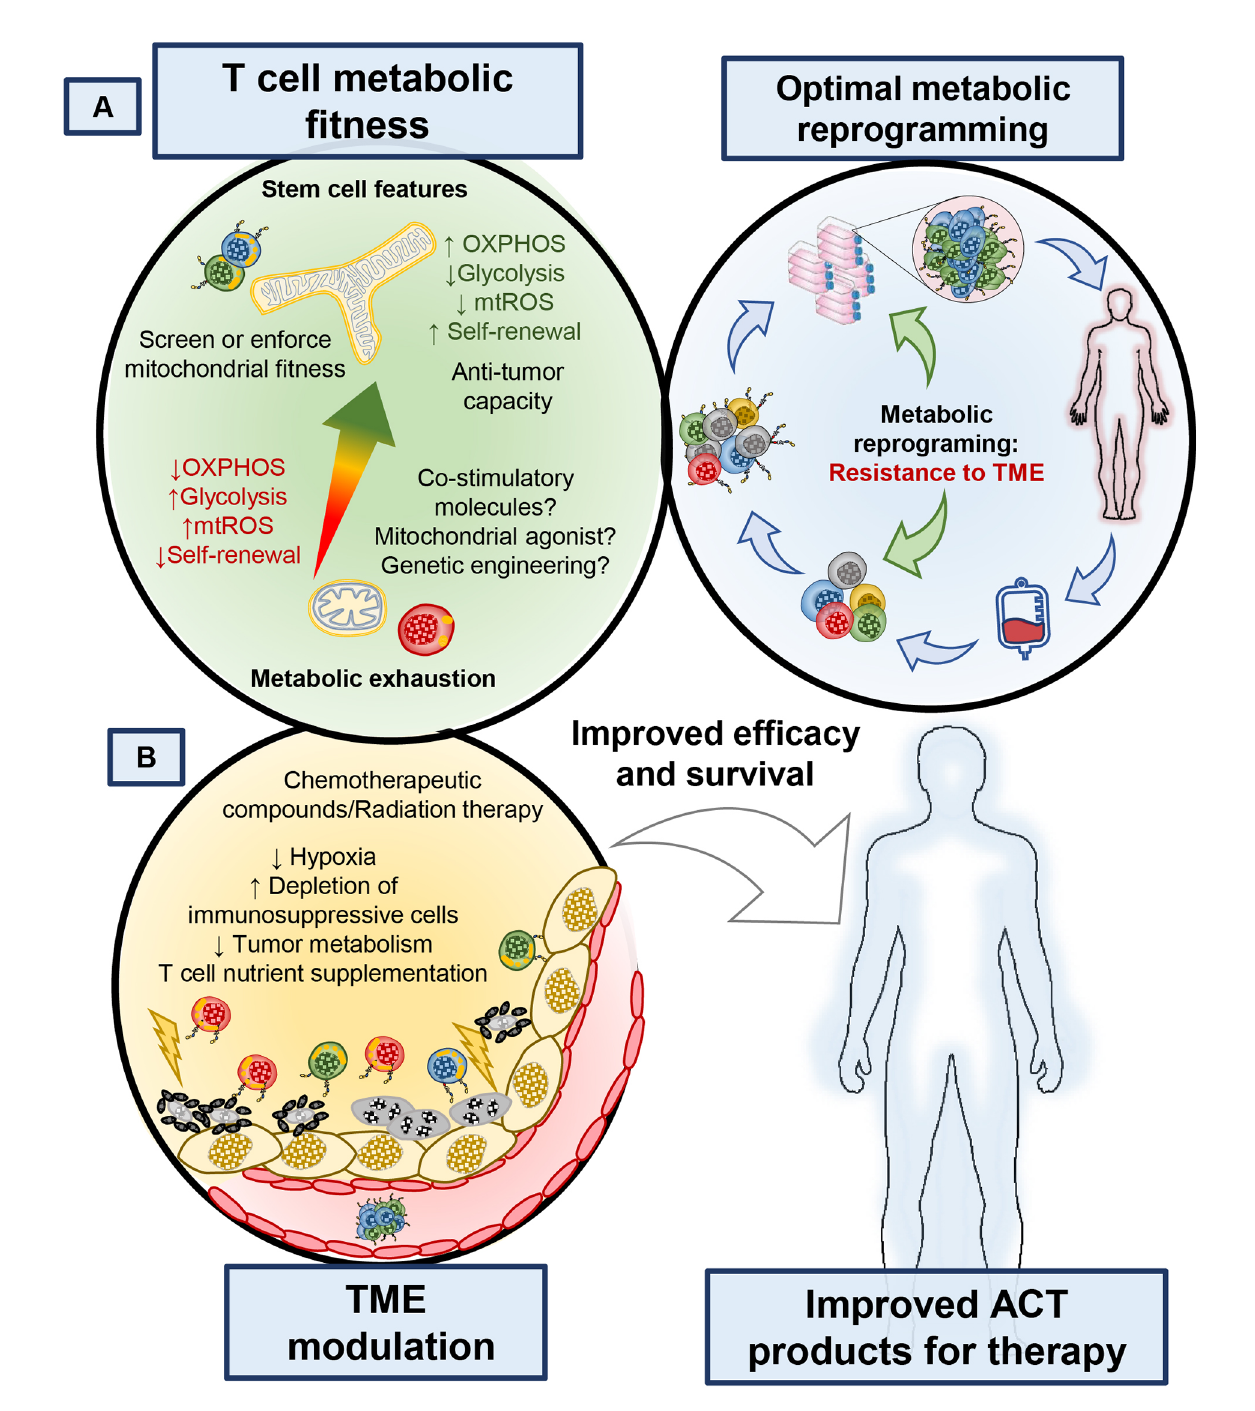
FIGURE 4 | Manipulating the ability of T cells to withstand metabolic stress or altering the metabolism of tumors can enhance the therapeutic potential of T cell- based therapies. (A) Identifying markers that identify metabolically competent T cells, as well as understanding how small molecule compounds, biologics or receptor ligands could improve T cell metabolism will bring new targets to improve the ef fi cacy of T cell products. (B) Better understanding of how the tumor microenvironment is affected by current therapies could provide new avenues to target both T cell and tumor metabolism to bolster immunotherapies. Enriching metabolically fi t T cells during T cell isolation from whole blood or including metabolism modulating agents during TIL and CAR T cell expansion or altering CAR design of T cells could improve the survival of patients treated with cellular